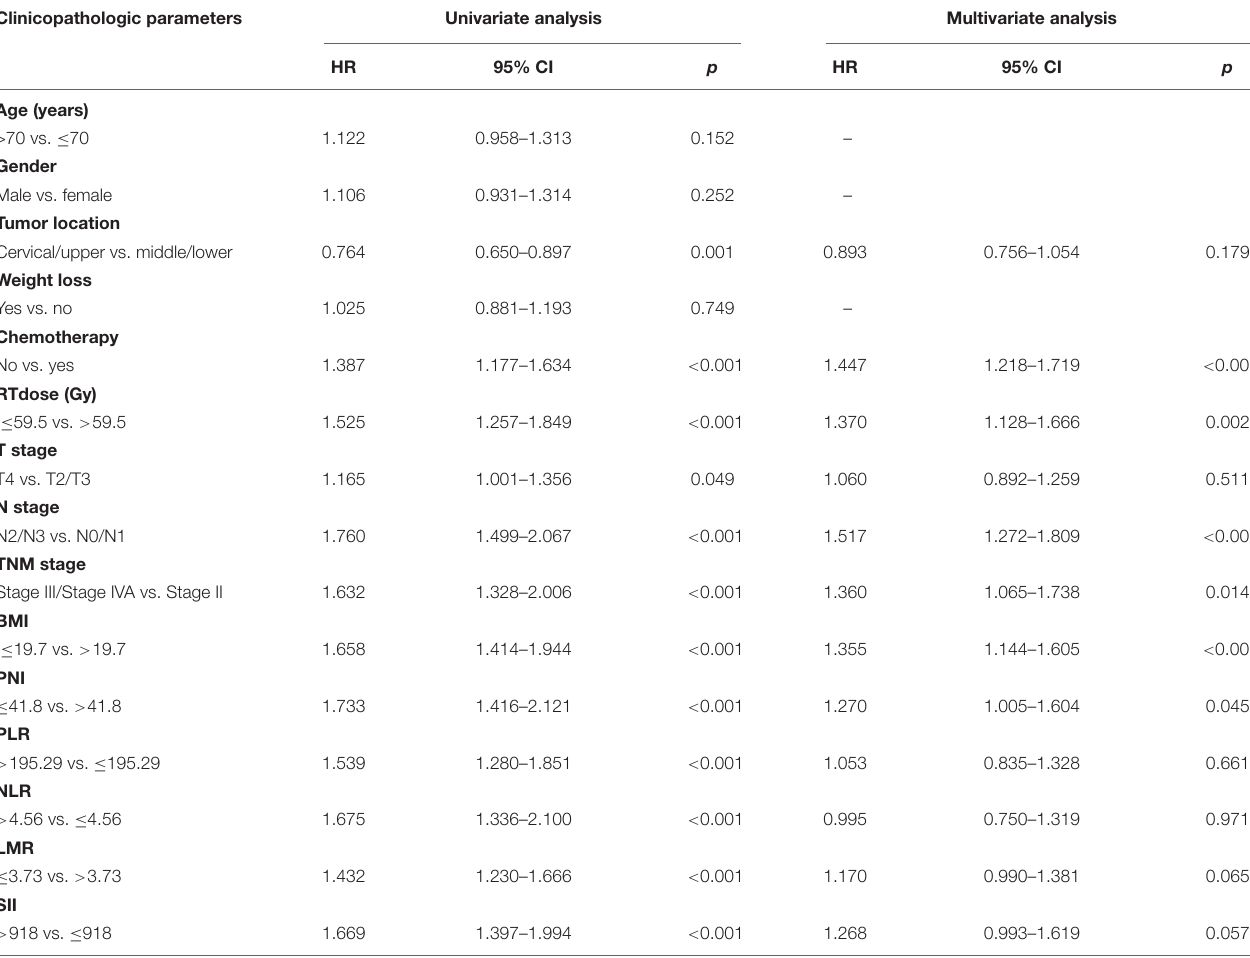
TABLE 2 | Predictors of overall survival: univariate and multivariate Cox proportional hazards models. Clinicopathologic parameters Univariate